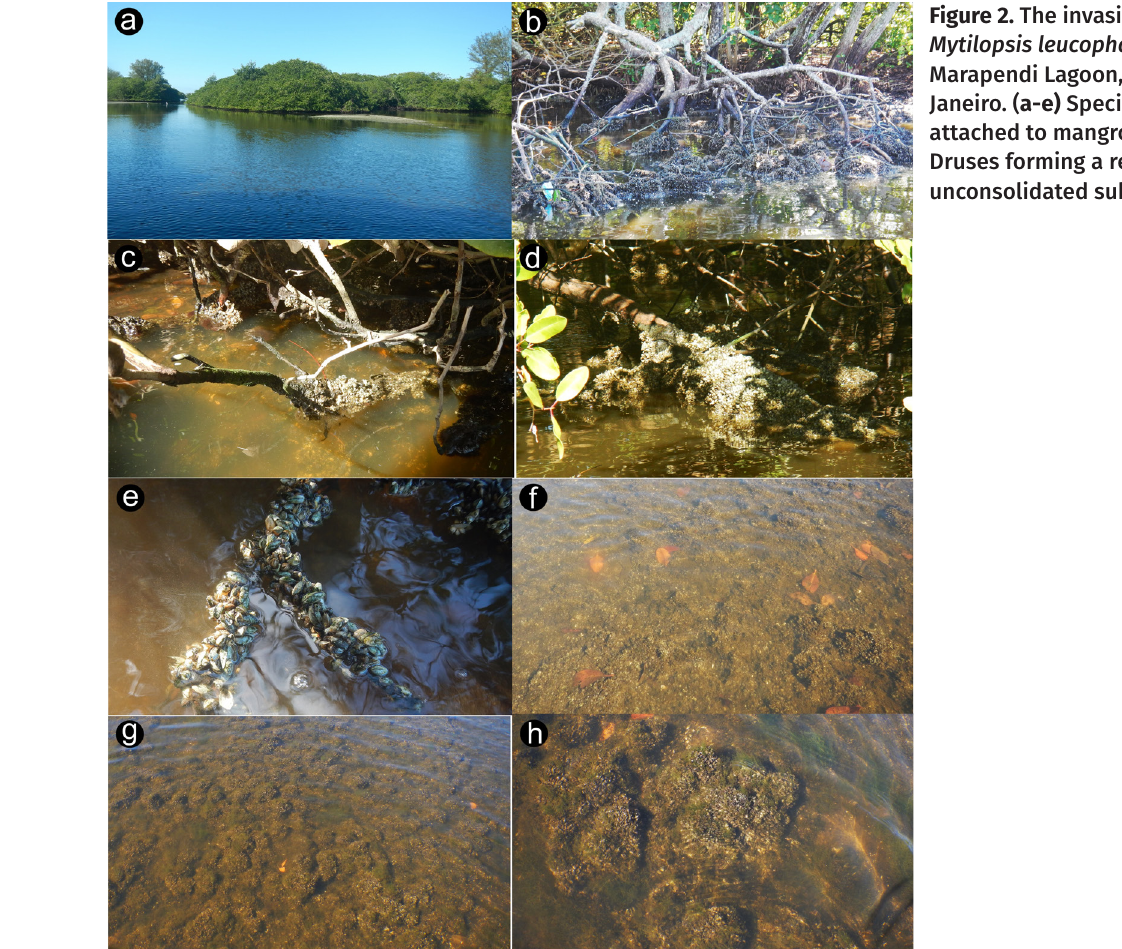
Figure 2. The invasion of Mytilopsis leucophaeata in Marapendi Lagoon, Rio de Janeiro. ( a-e) Specimens attached to mangrove roots. ( f-h) Druses forming a reef over the unconsolidated